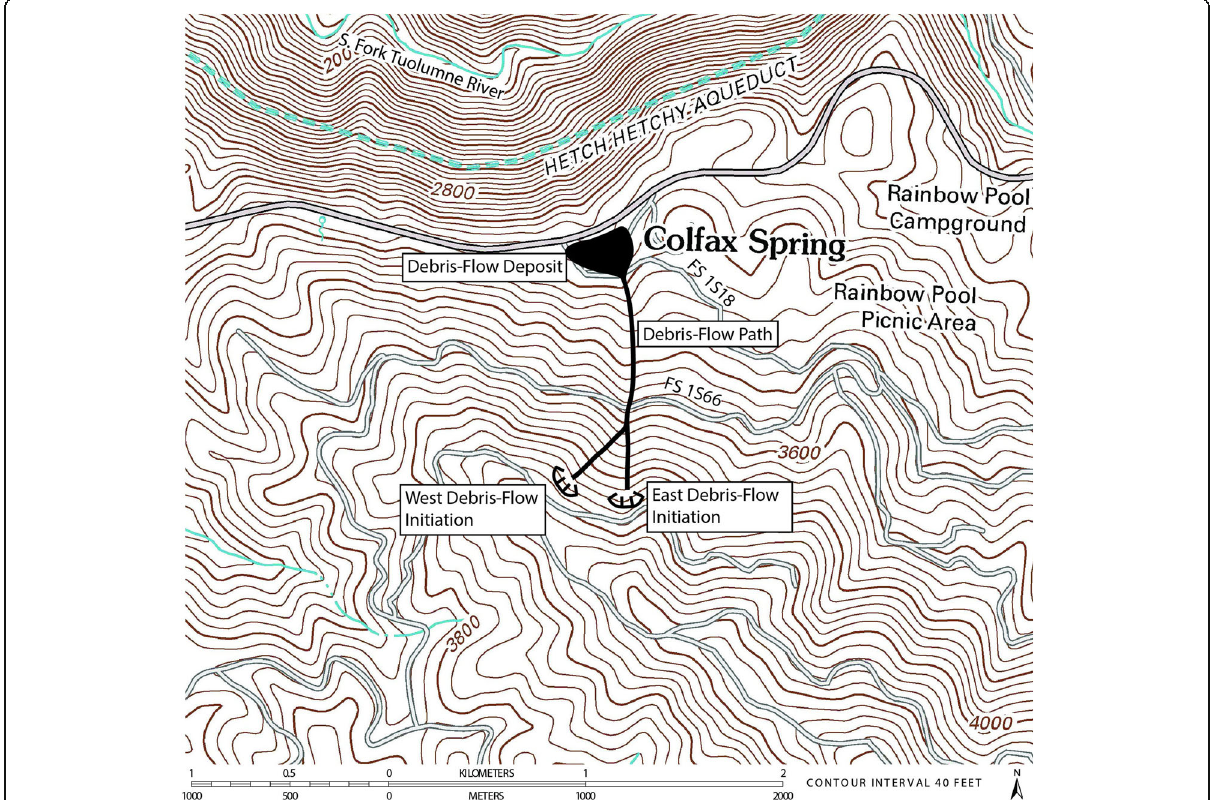
Fig. 2 A detailed map for the area affected by the Pilot Ridge debris flow in 1997. The deposition area covers the location of the house and outbuilding affected by the debris flow. The east-west highway adjacent to the highway is U.S. Highway 120 which provides access to Yosemite National Park to the east of this